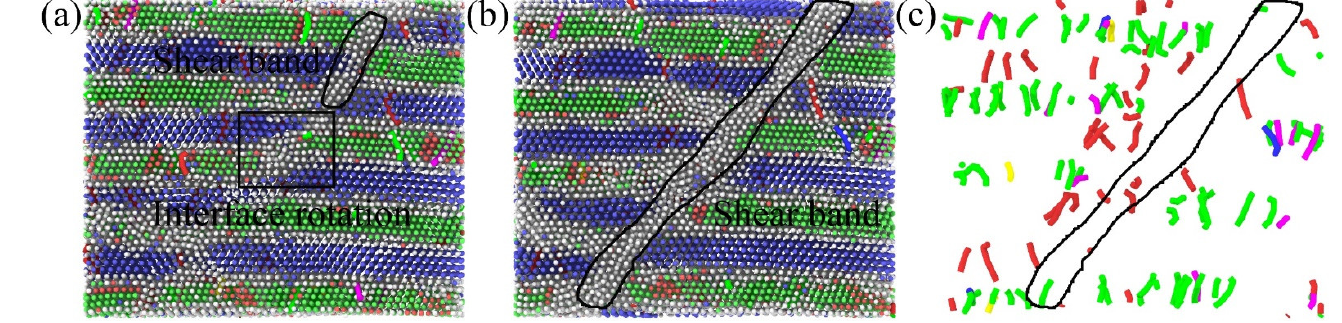
Figure 6. Snapshots of the local atomic defect evolution in the shear band formation. ( a ) ε = 0.13, ( b ) ε = 0.15, ( c ) dislocation lines at ε = 0.15. The rectangular area undergoes interface rotation and the ribbon area forms shear bands.